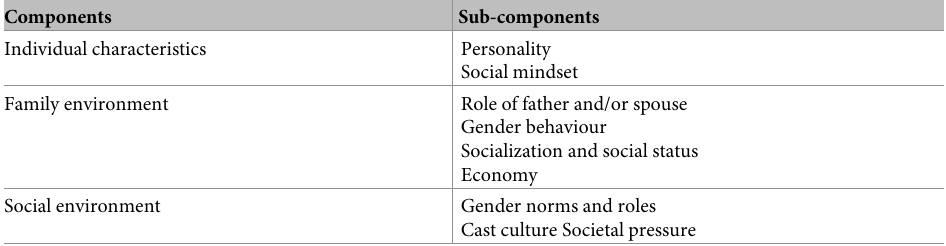
Table 2. Factors associated with the leadership development during childhood and